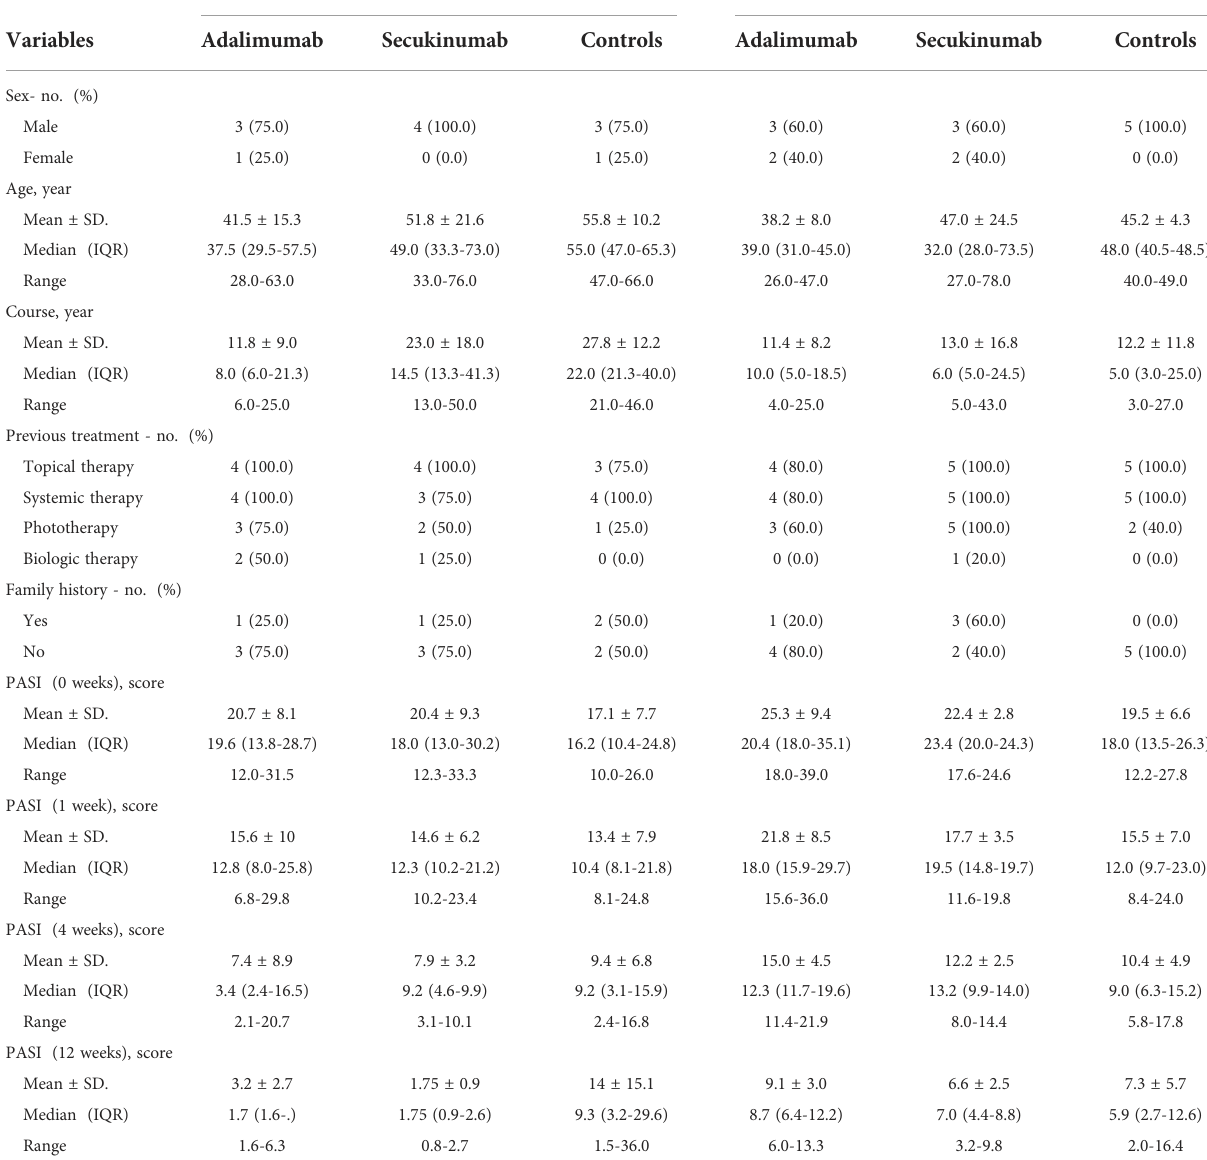
TABLE 1 Baseline characteristics of psoriasis